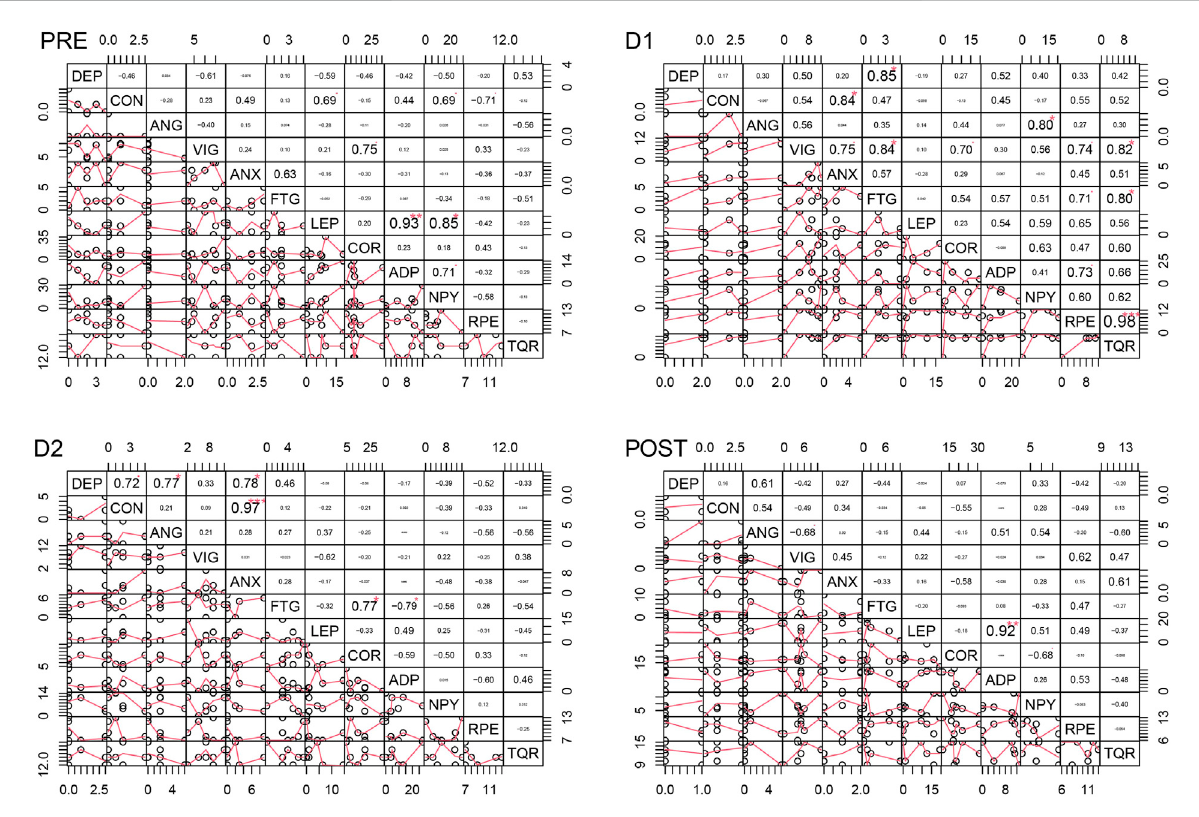
FIGURE 6 Correlation analyses for the control group at the four time points. DEP = Depression, CON = Confusion, ANG = Anger, VIG = Vigor, ANX = Tension-ANXiety, FTG = Fatigue, LEP = Leptin, COR = Cortisol, ADP = Adiponectin, NPY = Neuropeptide Y, RPE = Ratings of Perceived Exertion, TQR = Total Quality of